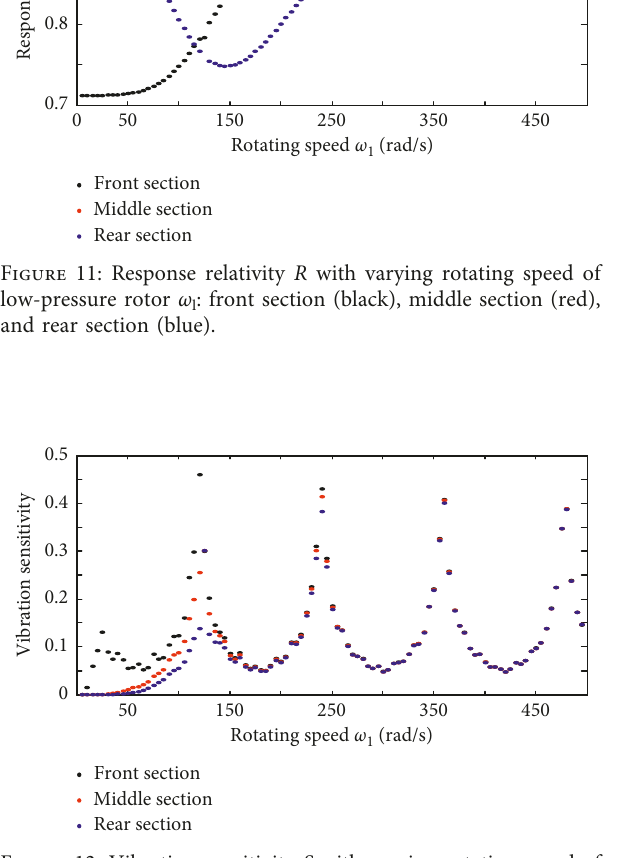
Figure 12: Vibration sensitivity S with varying rotating speed of low-pressure rotor ω l : front section (black), middle section (red), and rear section (blue).